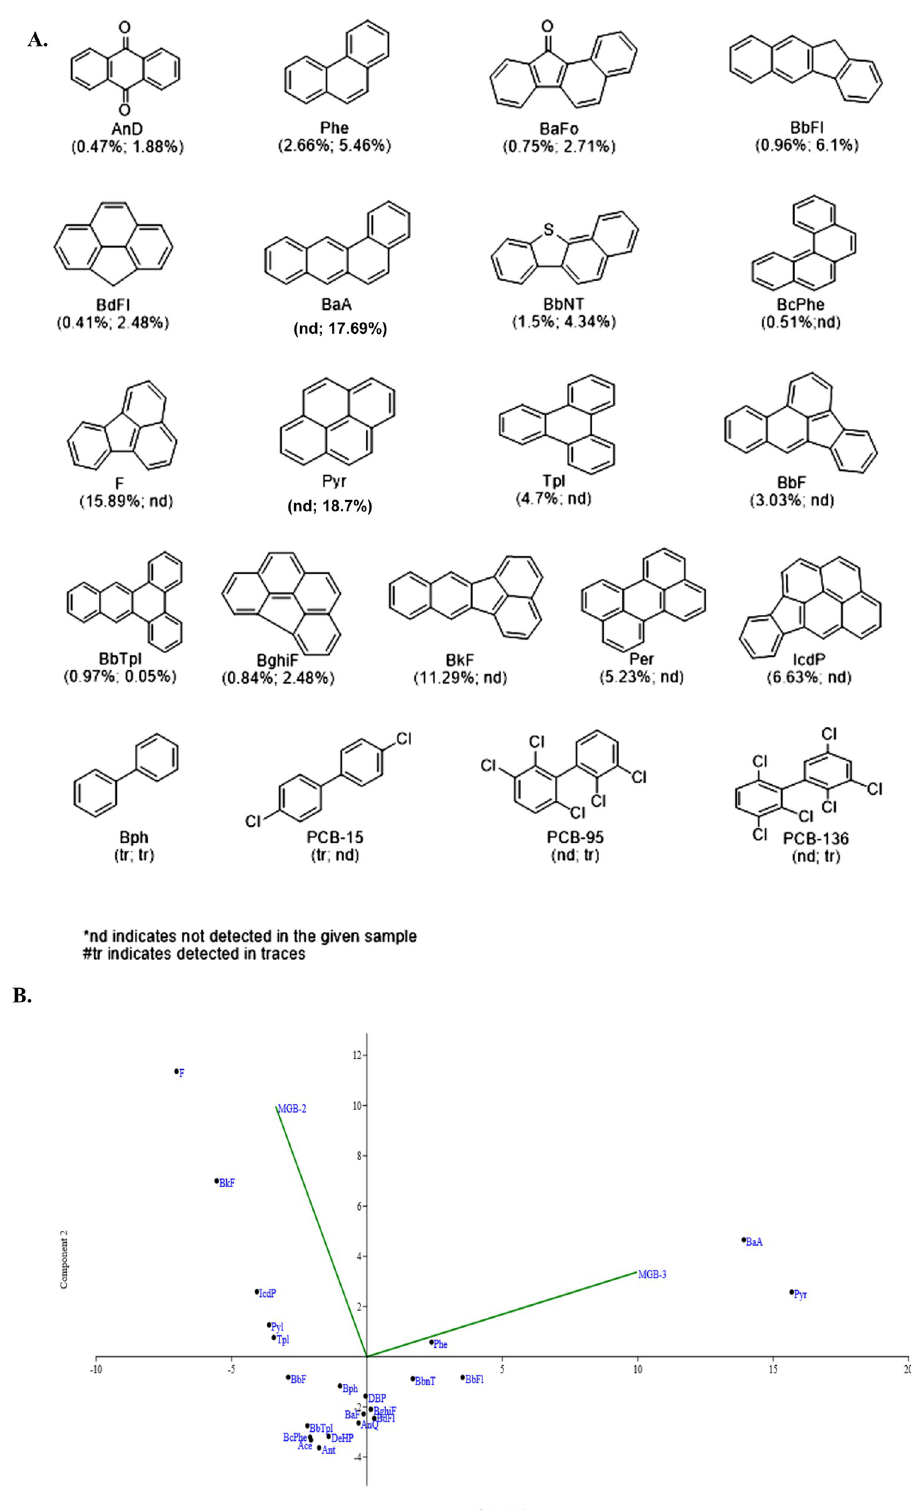
Fig 1. Structure and relative abundance of PAH and PCB identified in MGB-2 and MGB-3. (A) PAH found in MGB-2 & MGB-3 were 9,10-Anthracenedione (AnD), 11H-Benzo[a]fluoren-11-one (BaFo),